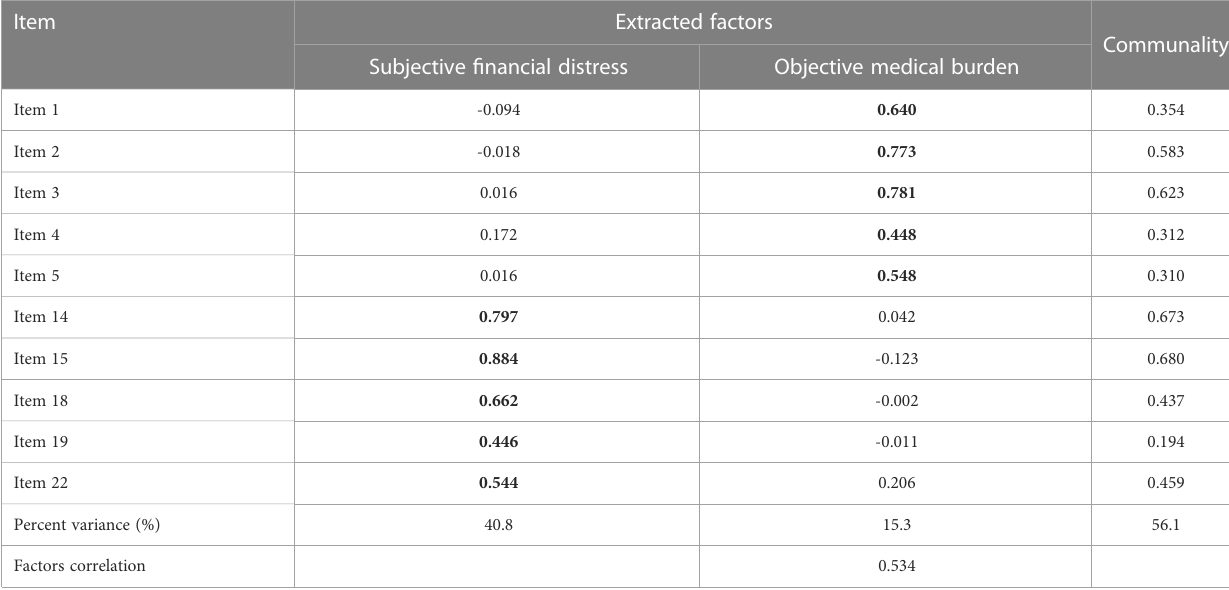
TABLE 2 Factor loadings of the remaining 10-item HARD using EFA.